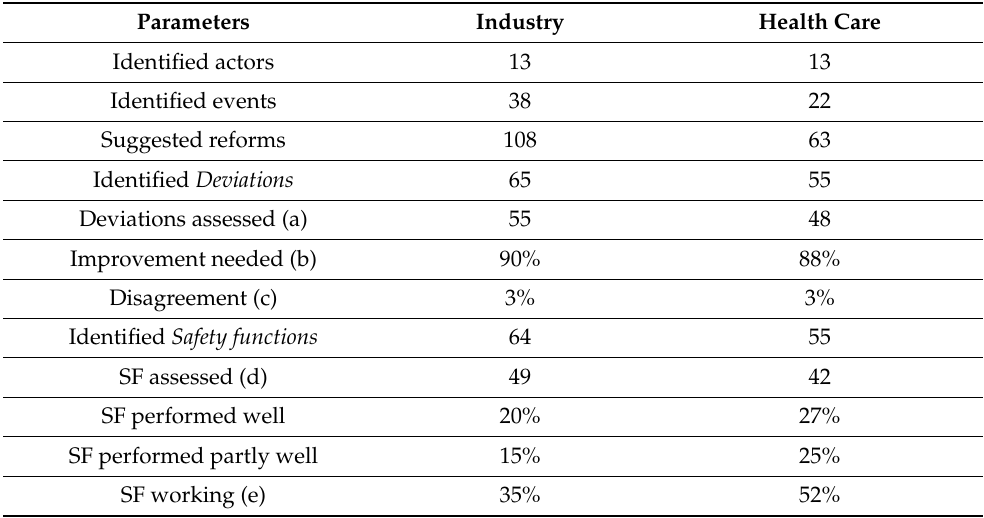
Table 11. Mean values for parameters in event investigations in industry and health